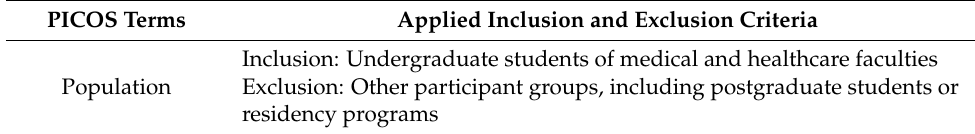
Table 1. A systematic review question formulated according to the PICOS